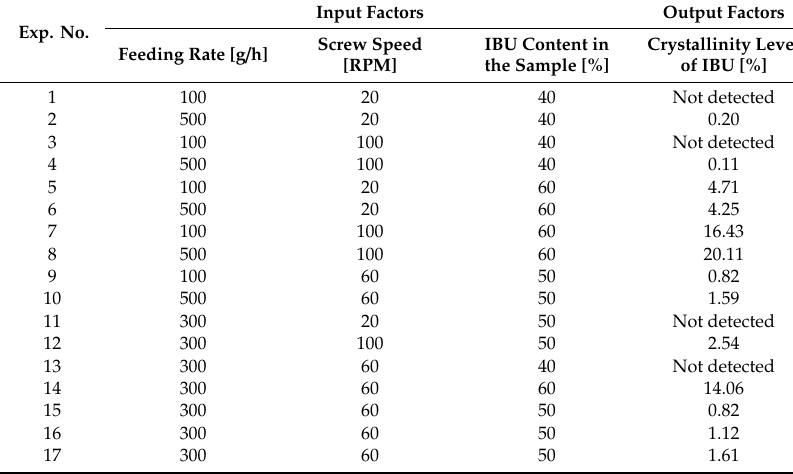
Experimentally determined crystallinity levels of IBU and HMI conditions of investigated